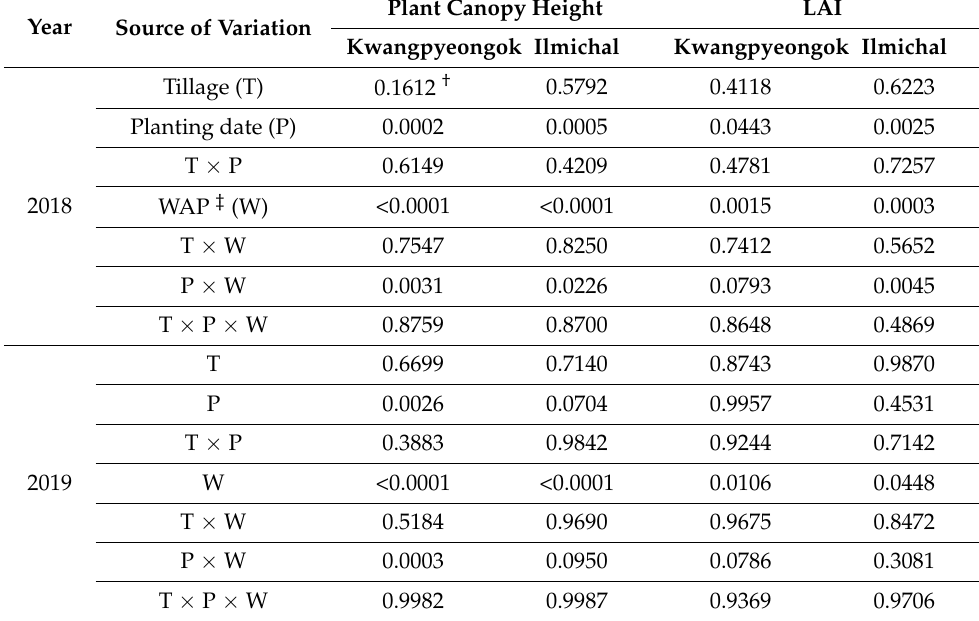
Table 2. Source of variation and probability level ( p -value) of plant canopy height and LAI for two maize cultivars (Kwangpyeongok and Ilmichal) over 4